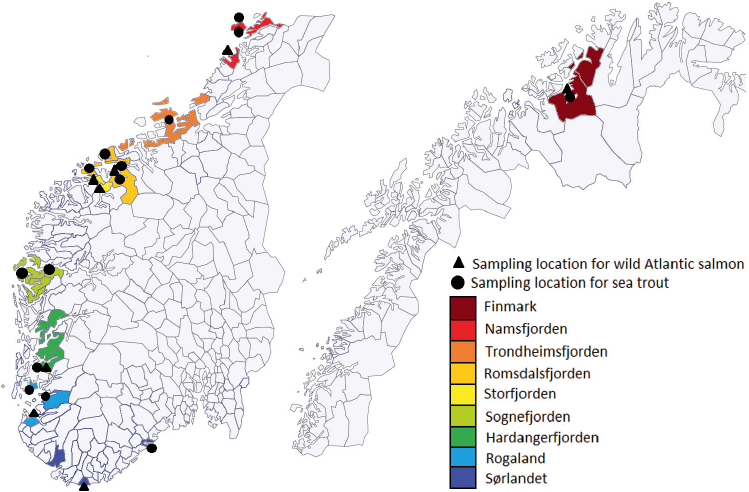
Fig. 1. Sampling locations for salmon lice from wild sea trout and wild Atlantic salmon. The corresponding regions based on data from fish farms are identi- fied by colour. The background map is derived from Global Administrative Ar- eas (2012) and R packages (Becker & Wilks 1993, 1995, Pebesma &